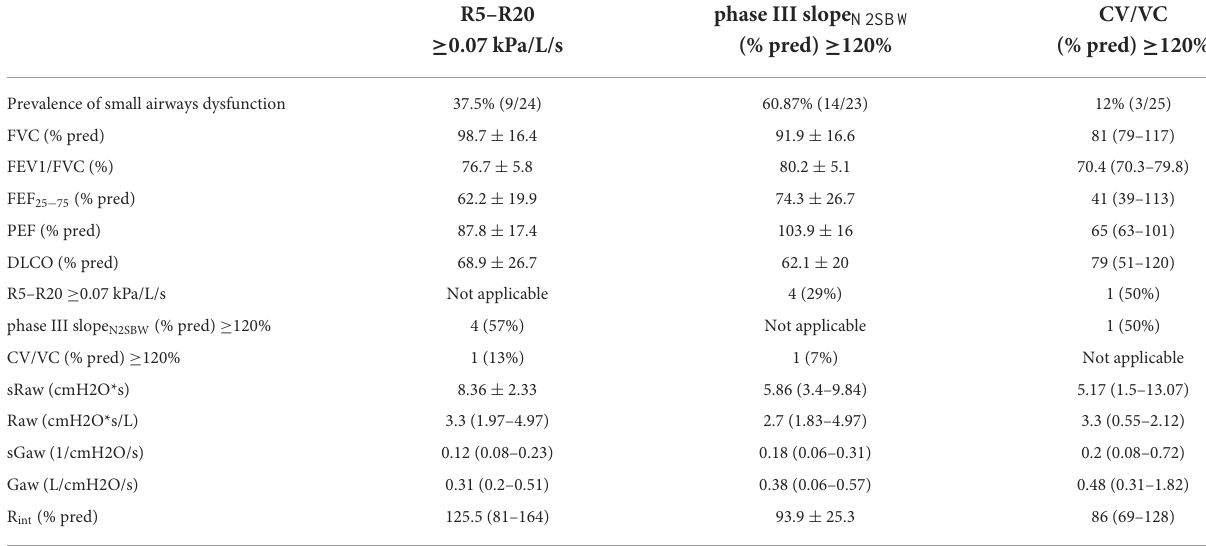
TABLE 2 Pulmonary function parameters of SSc patients with SAD diagnosed with the use of R5-R20, phase III slope N2SBW and